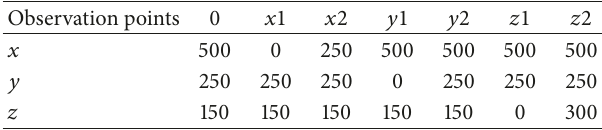
Table 2: Locations of the seven observation